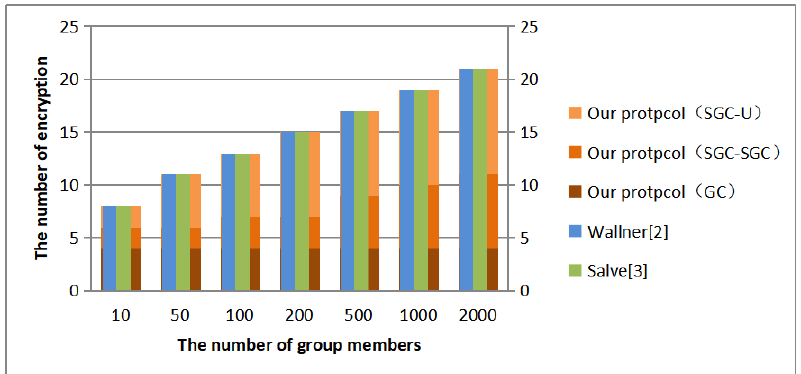
Figure 7. Computational overload of member joining.